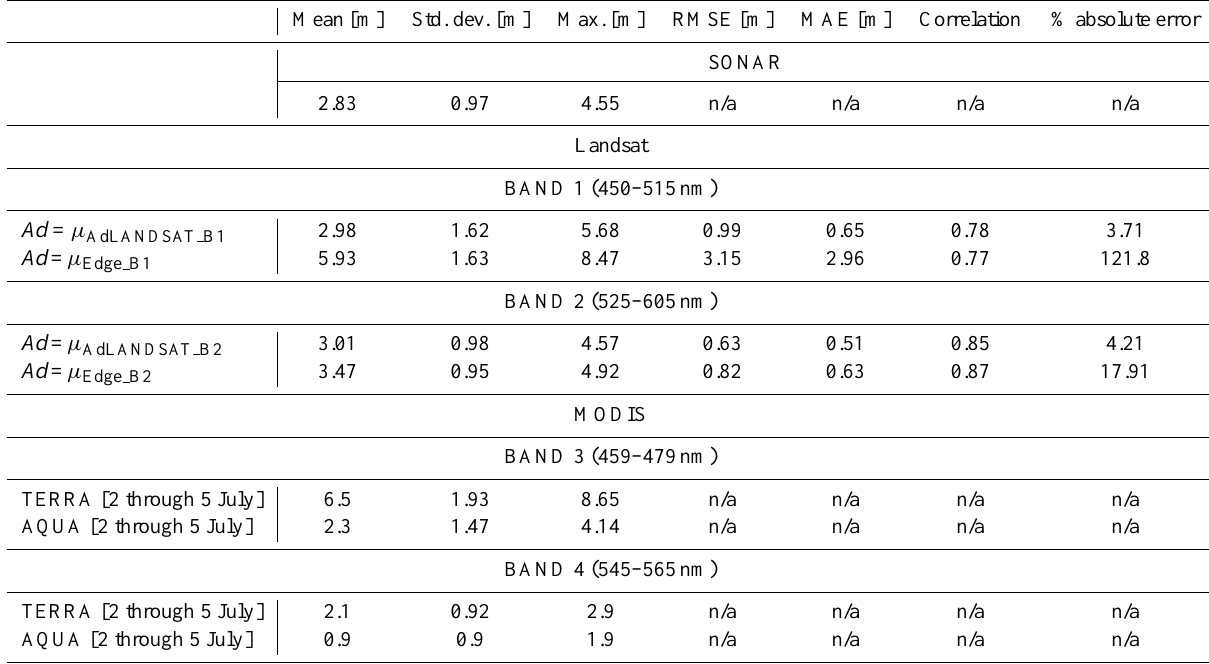
Table 2. Statistics on lake depth retrieval using different sensors, bands and hypothesis on the bottom albedo values Ad. Mean [m] Std. dev. [m] Max. [m] RMSE [m] MAE [m] Correlation % absolute error SONAR 2.83 0.97 4.55 n/a n/a n/a n/a Landsat BAND 1